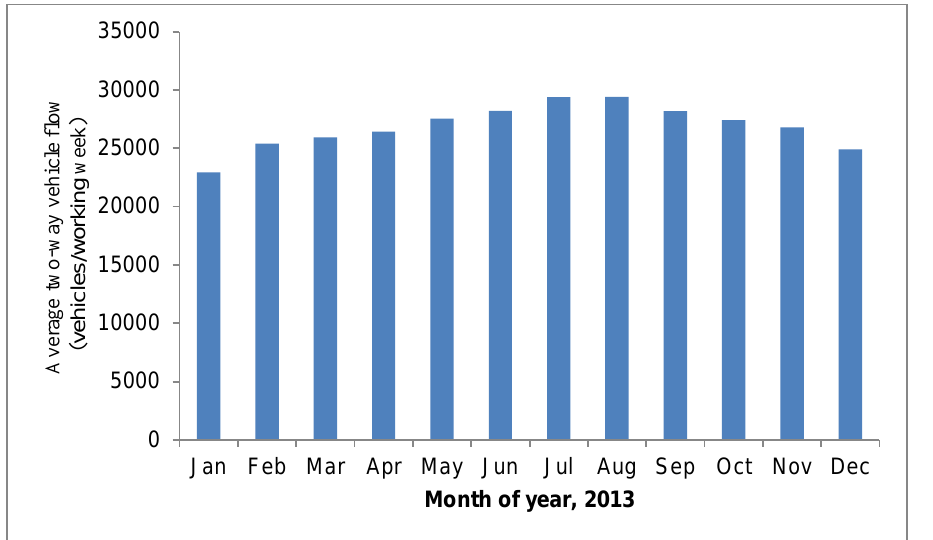
Figure 2. Seasonal variation (2013) in two-way flow at site #3 on the A354 (see Figure 1)